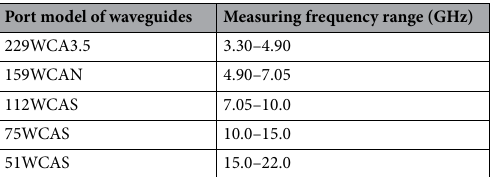
Table 10. Various pairs of waveguide model and range of frequencies.